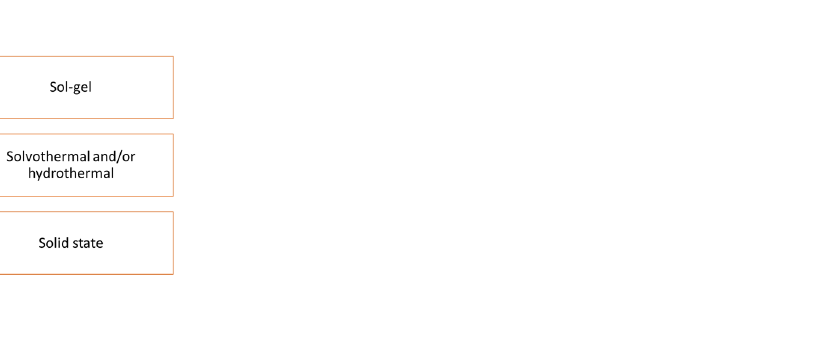
Figure 10. Most representative synthetic methods to obtain hybrid systems.